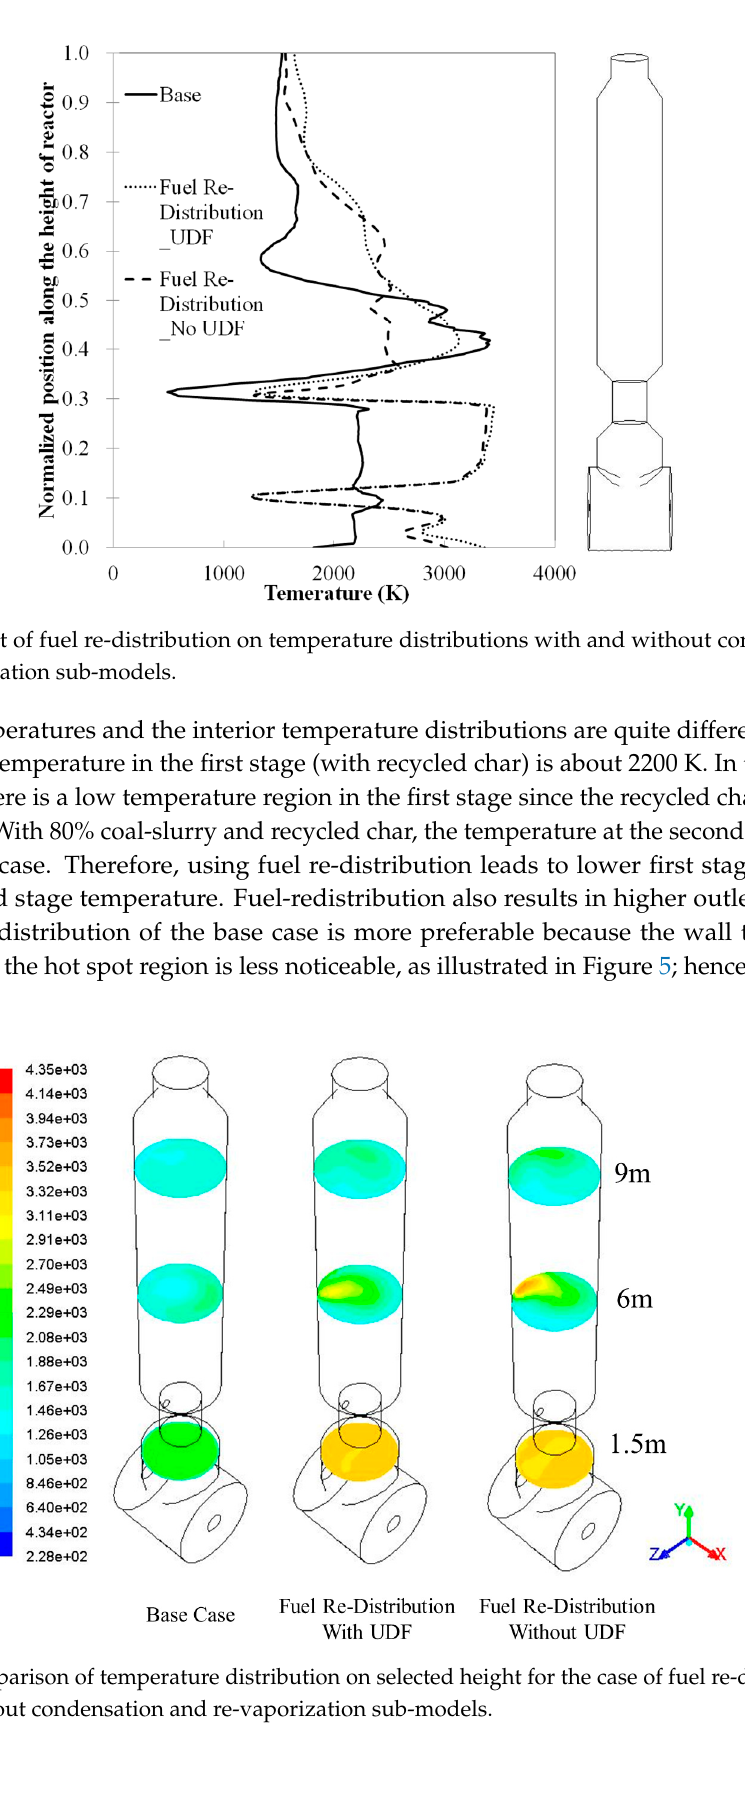
Table 10. Effect of operating pressure and oxygen amount on syngas composition and exit temperature.